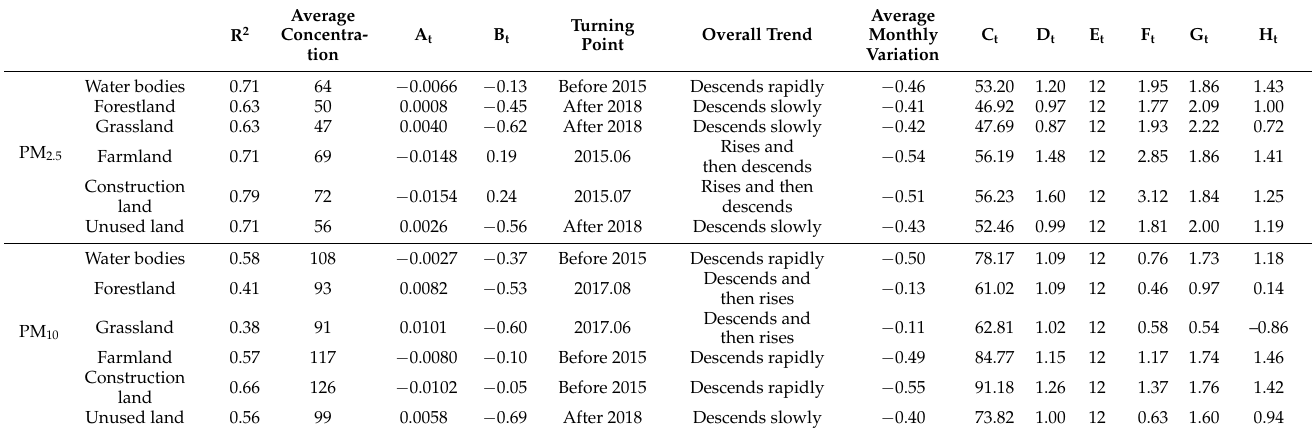
Table 5. Fitting parameters of the monthly PM